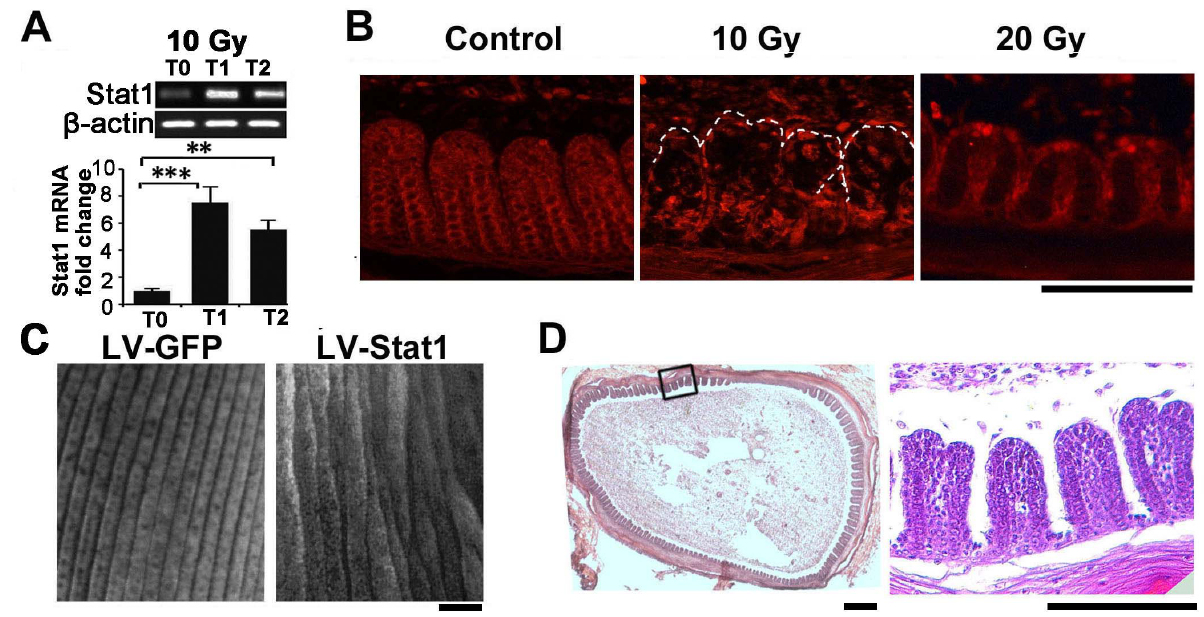
Figure 5. Involvement of Stat1 gene in IR-induced feather defects. (A) RT-PCR and densitometrical quantification showing increased Stat1 expression in the feather follicles. **, p , 0.01; ***, p , 0.001. (B) Stat1 antibody staining showing nuclear enrichment after IR exposure (T1 samples). (C) Whole-mount view of the feather epithelium after lentiviral-mediated Stat1 over-expression in the feather follicle. In control experiments, a lentivirus carrying GFP was used. (D) H&E analysis of Stat1 over-expressed feather follicle showing abnormal epithelial branching. Samples were collected 2 weeks after virus infection. Bar=100 m m.